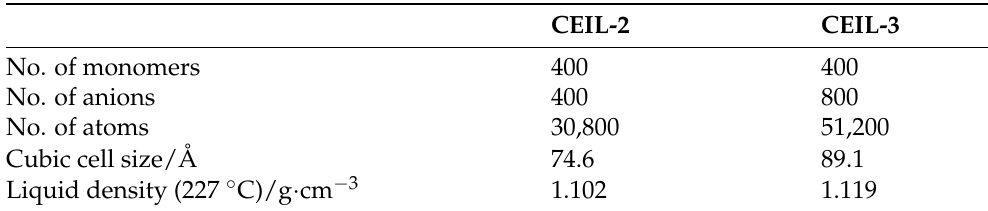
Table 1. Number of monomers and anions as well as the total number of atoms in each liquid system are reported. The equilibrium density and equilibrium cubic cell size were obtained at 227 ◦ C and 1